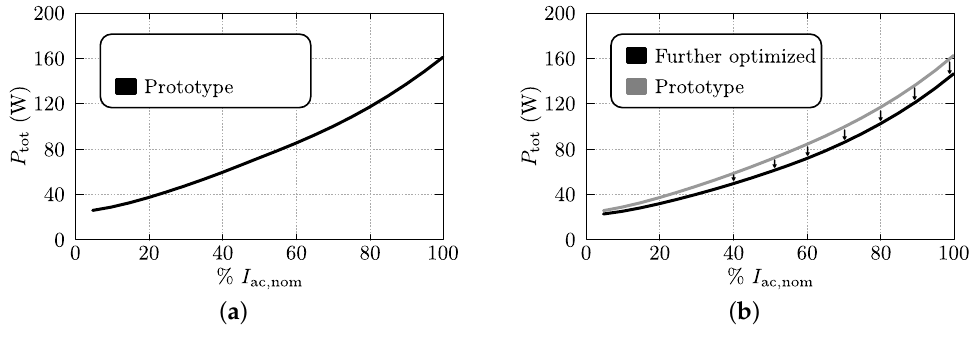
Figure 20. Calculated total losses of the 1-S DAB ac-dc converter implemented according to ( a ) converter design A (prototype converter) and ( b ) converter design B (further optimized).